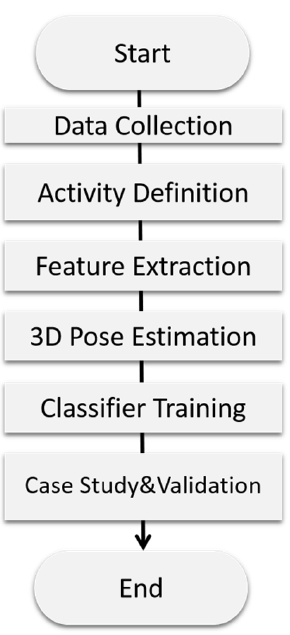
Figure 2. Research framework.